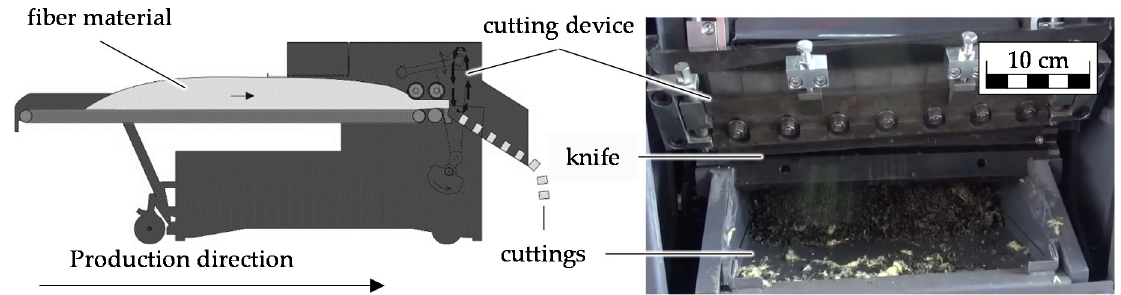
Figure 1. Schematic representation of the guillotine cutting [29].